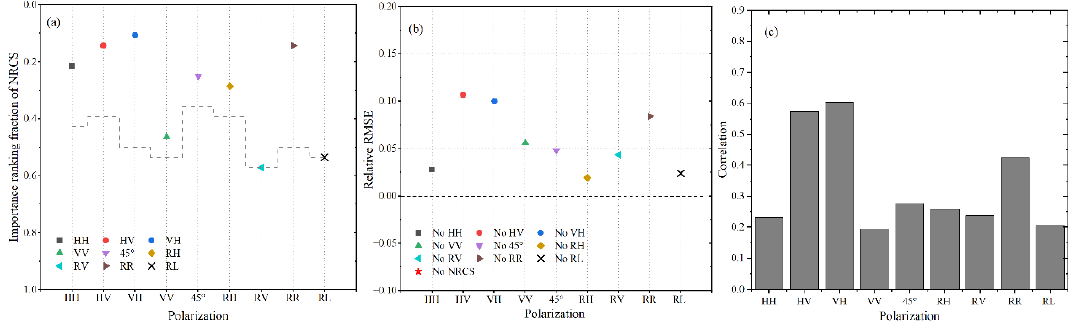
Figure 11. The importance of NRCS to SWH retrieval from single-polarization models. ( a ) The importance ranking of NRCS provided by XGBoost models normalized to 0 – 1. The dotted line represents the optimal feature sets under different polarizations. ( b ) The effect of removing NRCS on the SWH estimation from different polarized models. Different markers in various colors represent NRCSs of different polarizations. ( c ) The correlation between NRCS and ERA5 SWH under different polarizations.